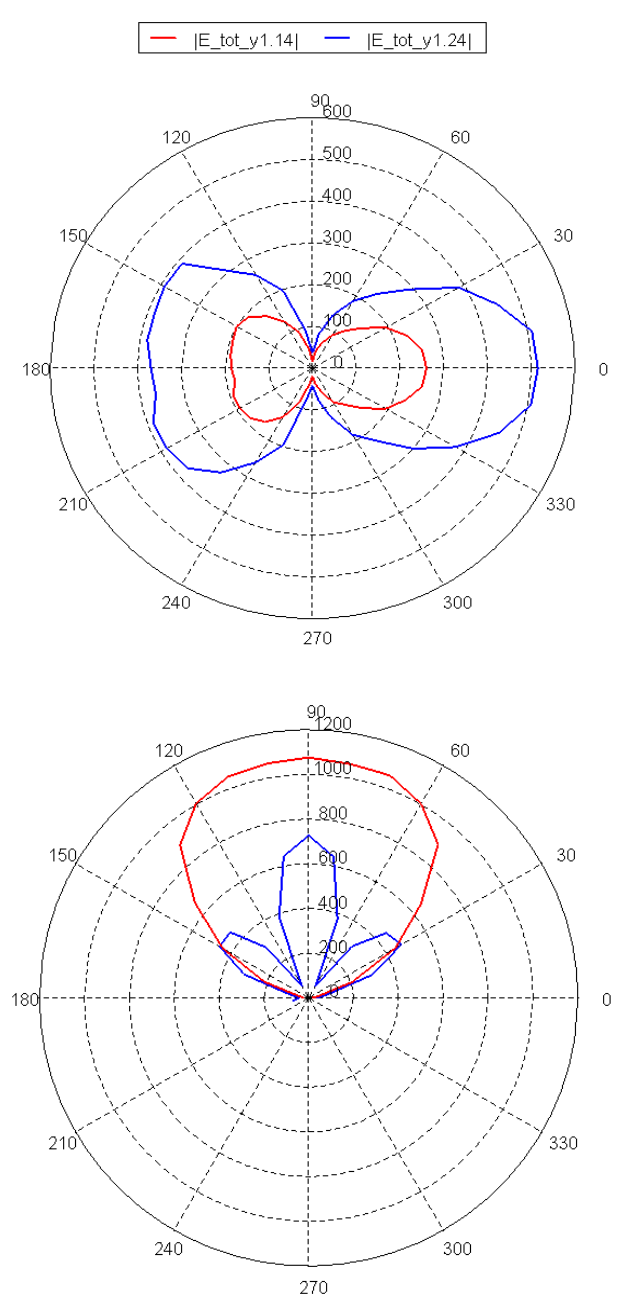
Figure 6. Comparison of the 2D radiation pattern of the electric Hertzian dipole at the positions y = 1.14 m and y = 1.24 m. Radiation frequency is 900 MHz with an amplitude of 1 2 I  dl = 1. Top: Radiation pattern for  = 0° and  = 0°–360°. Bottom: Radiation pattern for  = 0°–180° and  =